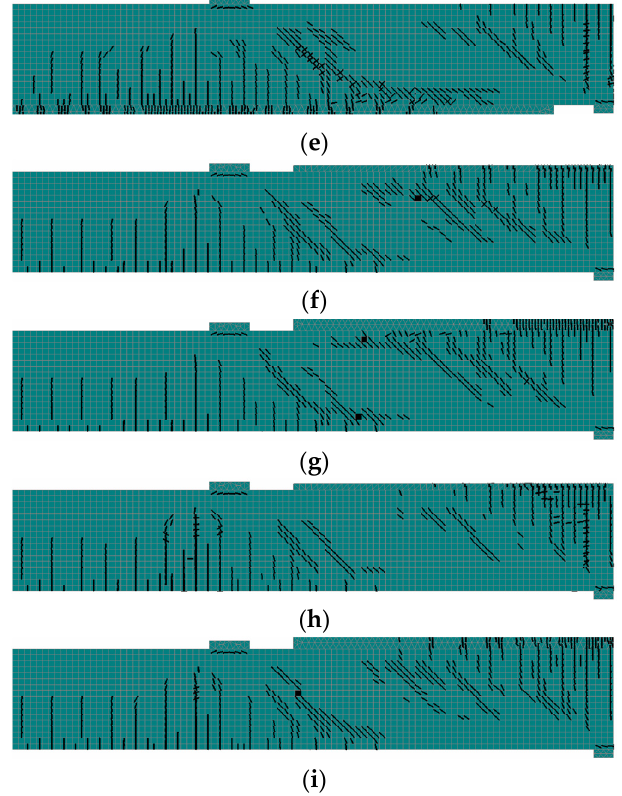
Figure 20. Predicted crack pattern: ( a ) Control; ( b ) S-C2; ( c ) S-C4; ( d ) S-P2; ( e ) SP-4; ( f ) H-C2; ( g ) H-C4; ( h ) H-P2; ( i ) HP-4.